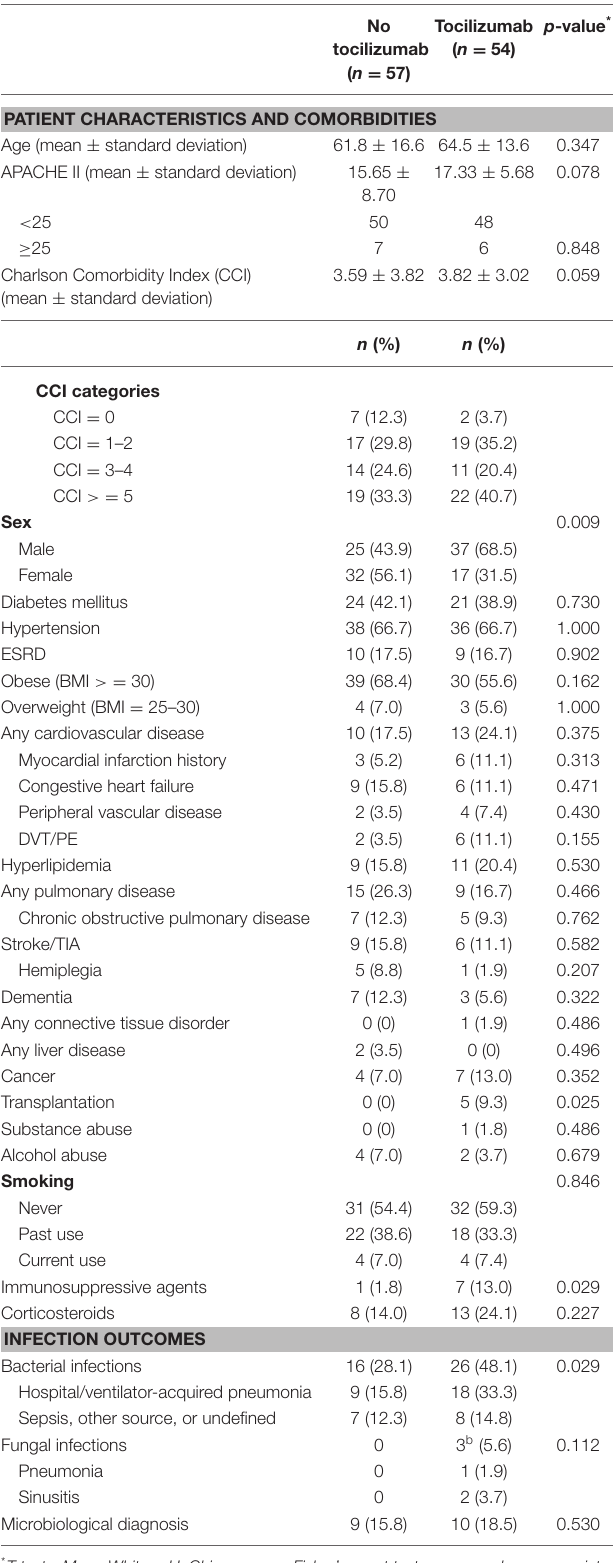
TABLE 1 | Co-morbidities and infection outcomes.